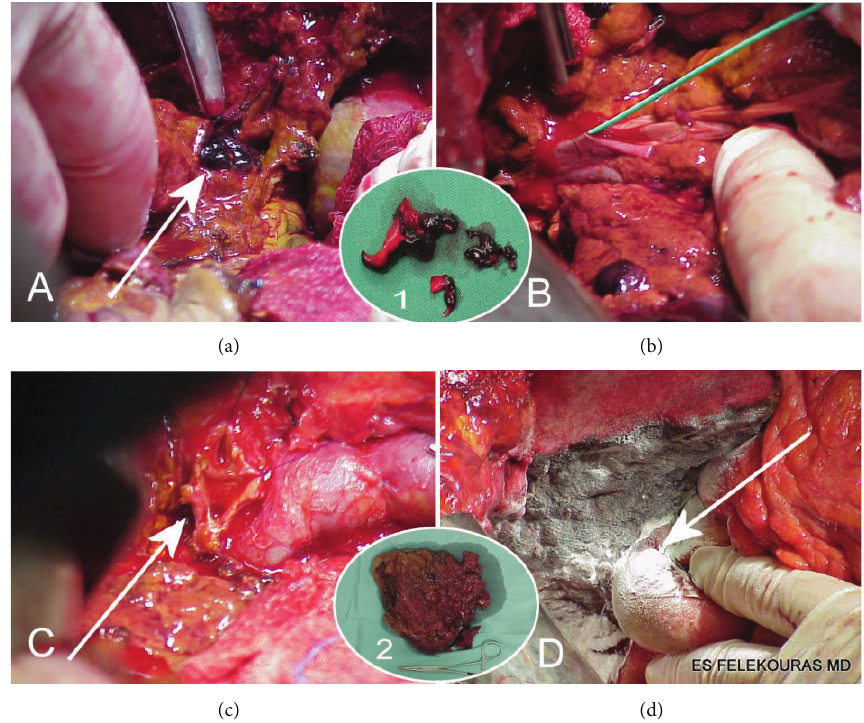
Figure 1: The procedure of right hepatic lobectomy for acute portal and RHA injury following laparoscopic cholecystectomy. (a) The thrombi in the portal vein (white arrow). (b) Thrombectomy of the main truck of the portal vein. (c) The bile duct bifurcation before hepatic lobectomy (white arrow). (d) Right hepatic lobectomy with hepaticojejunostomy on the left (white arrow). Inset 1. The thrombi of the portal vein after thrombectomy. Inset 2. The resected necrotic right hepatic